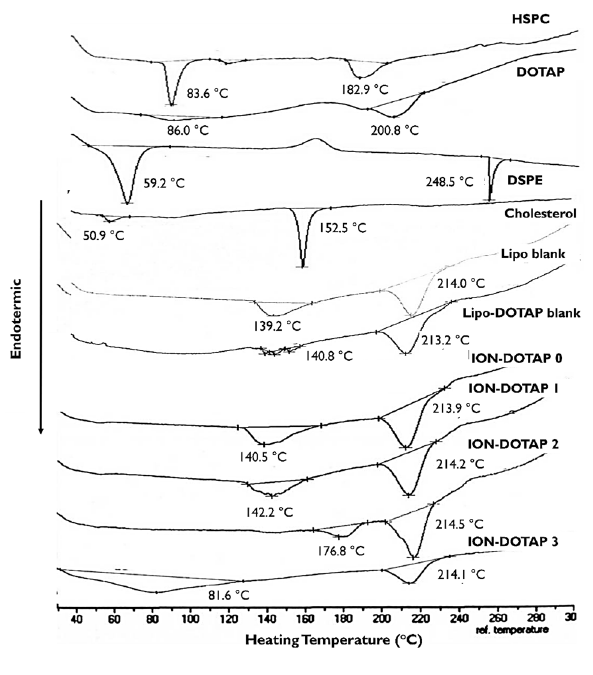
Figure 5. Thermogram profile of HSPC, DOTAP, DSPE-mPEG2000, Cholesterol, Lipo-Blank, Lipo-DOTAP Blank, ION-DOTAP-0, ION-DOTAP-1, ION-DOTAP-2, and ION-DOTAP-3.